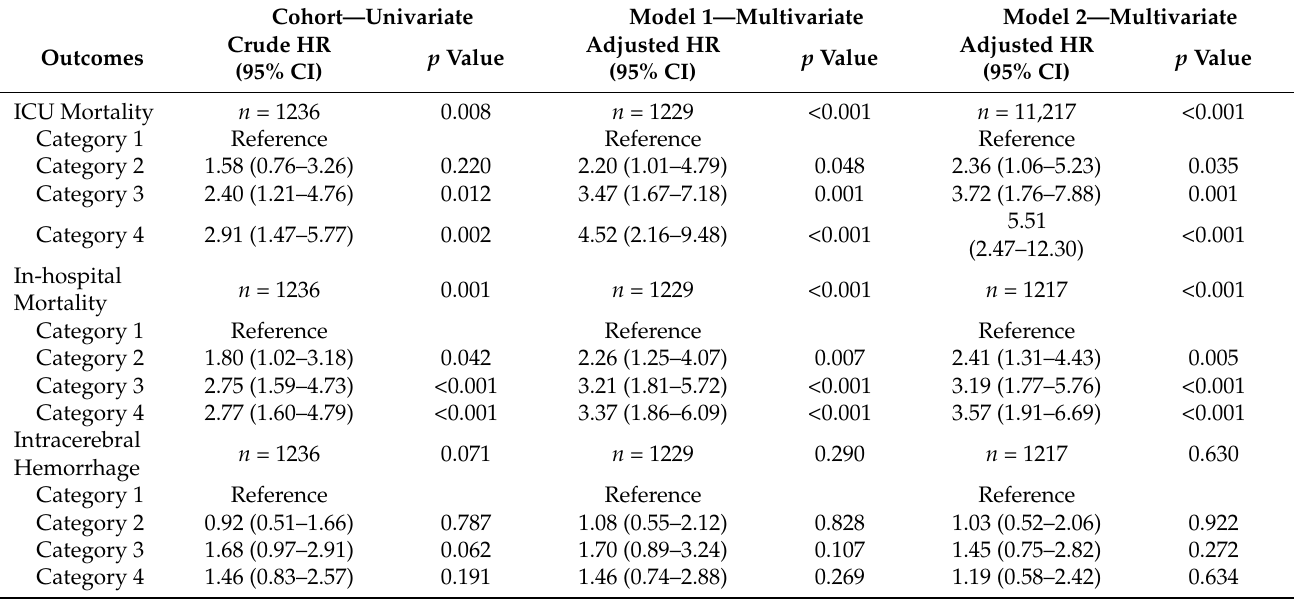
Table 2. Association between different anion gap levels and outcomes among stroke patients. Cohort—Univariate Model 1—Multivariate Model